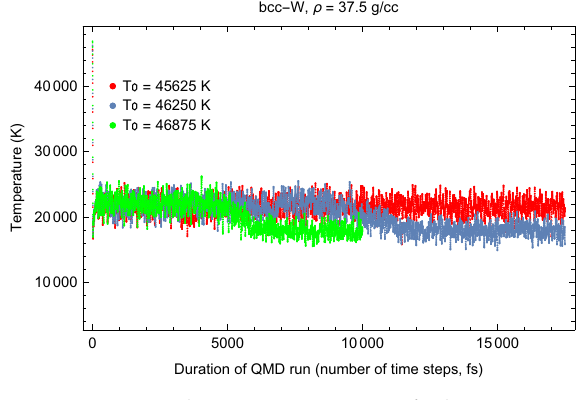
Figure 9. The same as in Figure 1 for